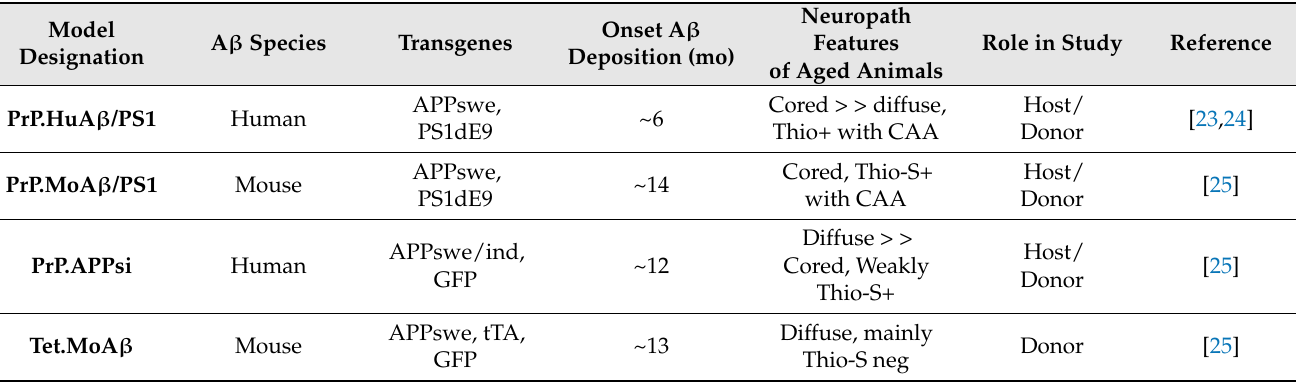
Table 1. List of the mouse models used in this